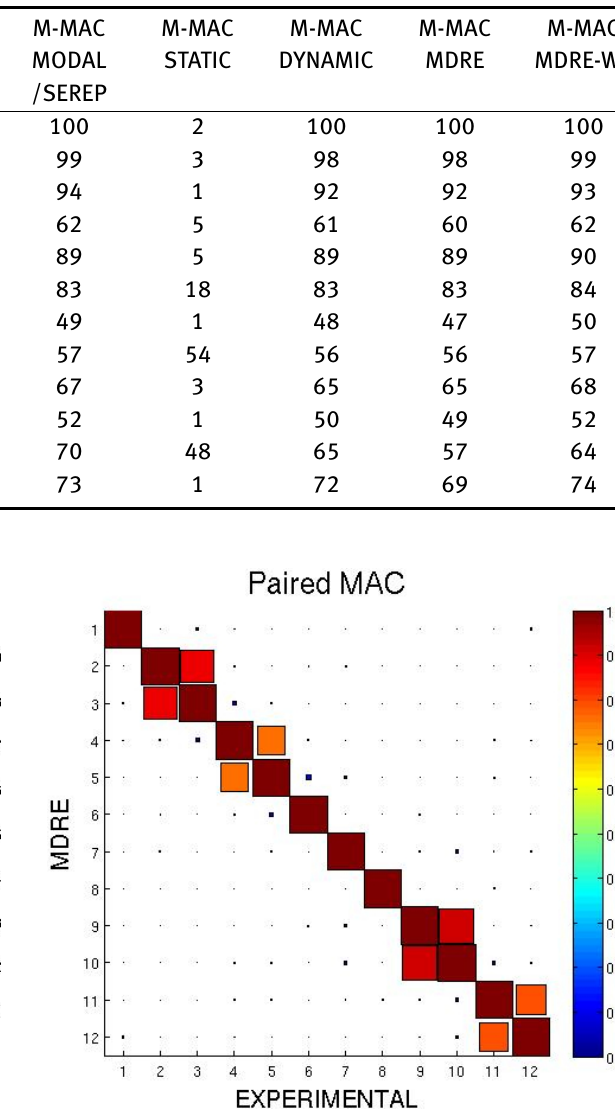
Figure 13: MAC: MSE DYNAMIC vs. Exp. Figure 14: MAC: MSE MDRE vs.